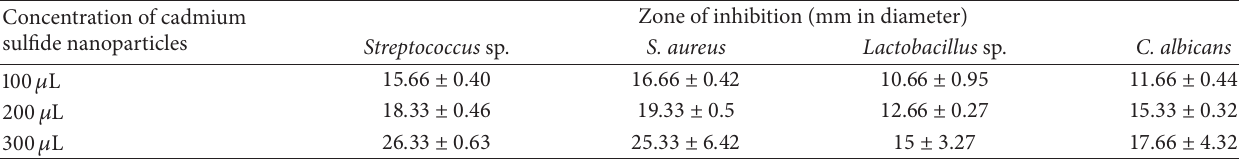
Table 1: Zone of CdS nanoparticles against oral pathogenic microorganisms.